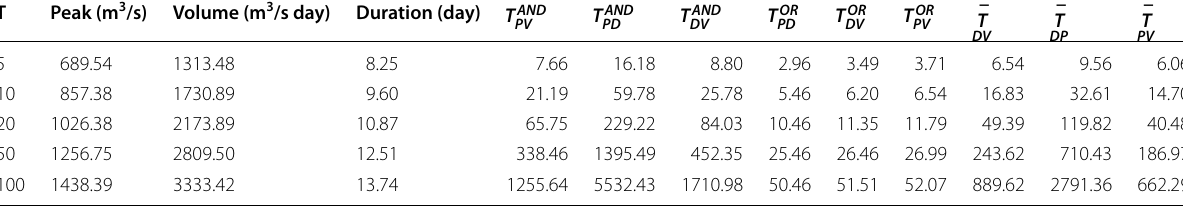
Table 7 Comparison of univariate, bivariate return periods for flood characteristics (year)